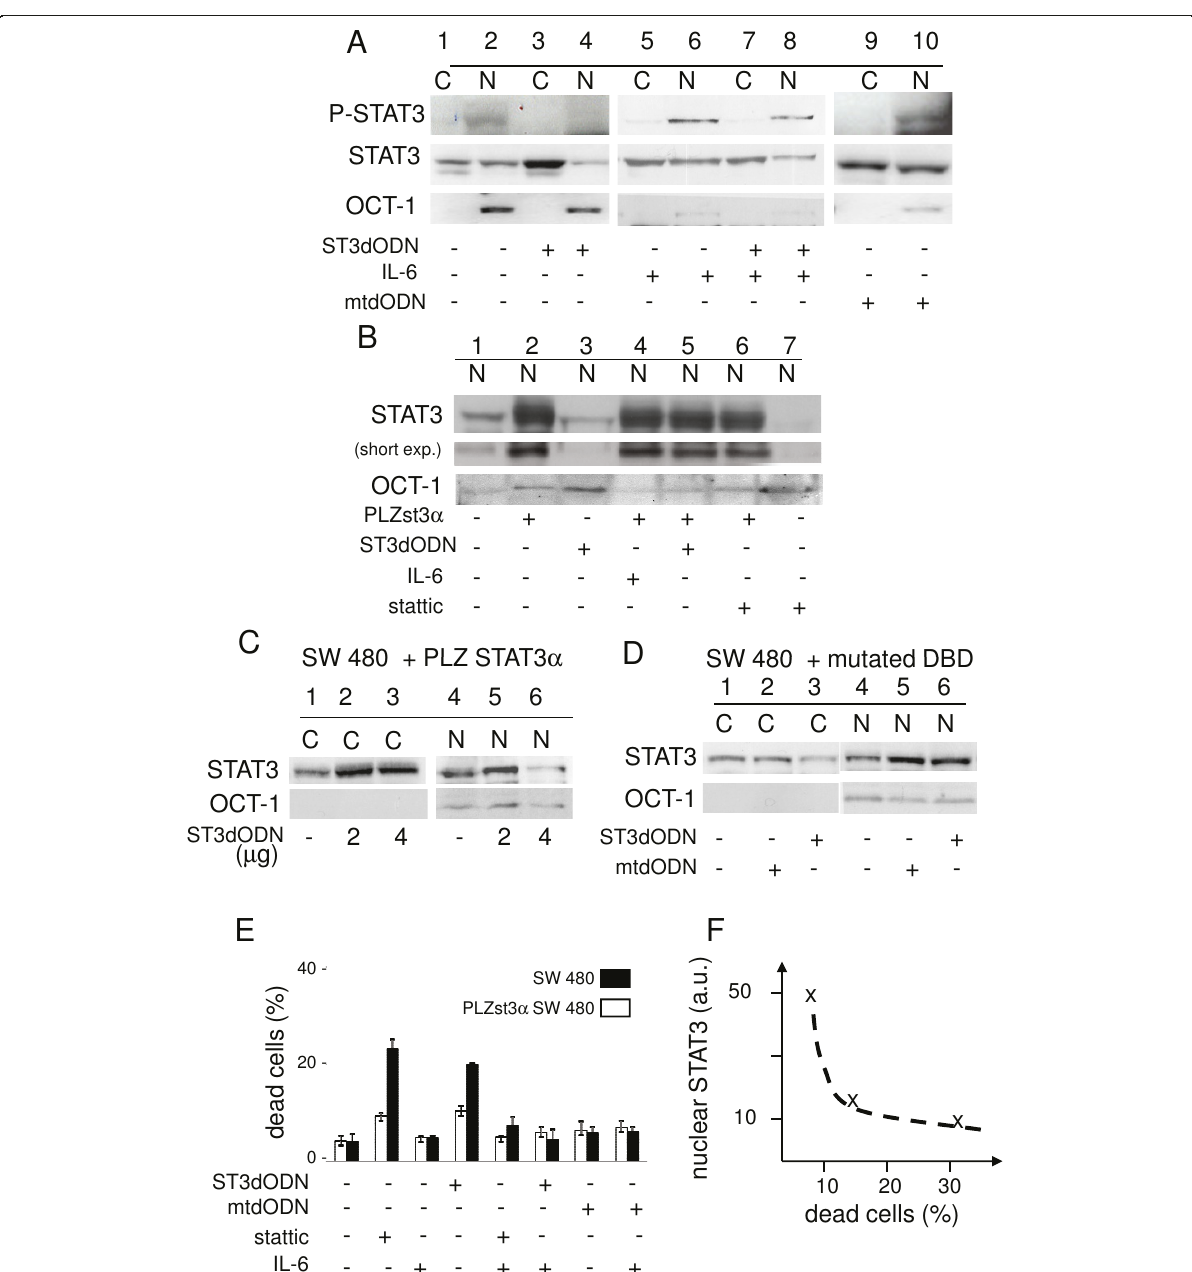
Figure 6 Reversal of STAT3-decoy ODN-mediated inhibition of STAT3 nuclear translocation and cell death by IL-6 activation or overexpression of STAT3 . A : Nuclear STAT3 in IL-6- and STAT3-decoy ODN-treated cells. Non-treated (1, 2, 3 and 4), IL-6 treated (50 ng/ml, 16 h) (5, 6, 7 and 8) cells, non-transfected (1, 2, 5 and 6), STAT3-decoy ODN-transfected (2 μ g/ml) (3, 4, 7 and 8) cells. B : nuclear STAT3 in STAT3- overexpressing cells transfected with STAT3-decoy ODN. Non-transfected (1, 3 and 7) and STAT3 plasmid (PLZst3 a ) (2, 4, 5 and 6) transfected cells. Stattic (6 and 7), STAT3-decoy ODN (lanes 3 and 5), or IL-6 (4 and 7) -treated cells. Diminished nuclear STAT3 in STAT3-overexpressing cells, treated with STAT3-decoy ODN or Stattic (5 μ M) (compare 2, 5 and 6) (short exposure). (nuclear extracts are shown). C : Increased STAT3-decoy ODN prevents overexpressed STAT3 nuclear entry. ST3-PLZst3 a plasmid-transfected cells transfected with 2 μ g (2, 5), 4 μ g (3, 6) or no (1, 4) decoy ODN. D : Nuclear accumulation of overexpressed DBD mutated STAT3: control (1 and 4), mutated STAT3-decoy ODN- (2 μ g/ml) (2 and 5) or